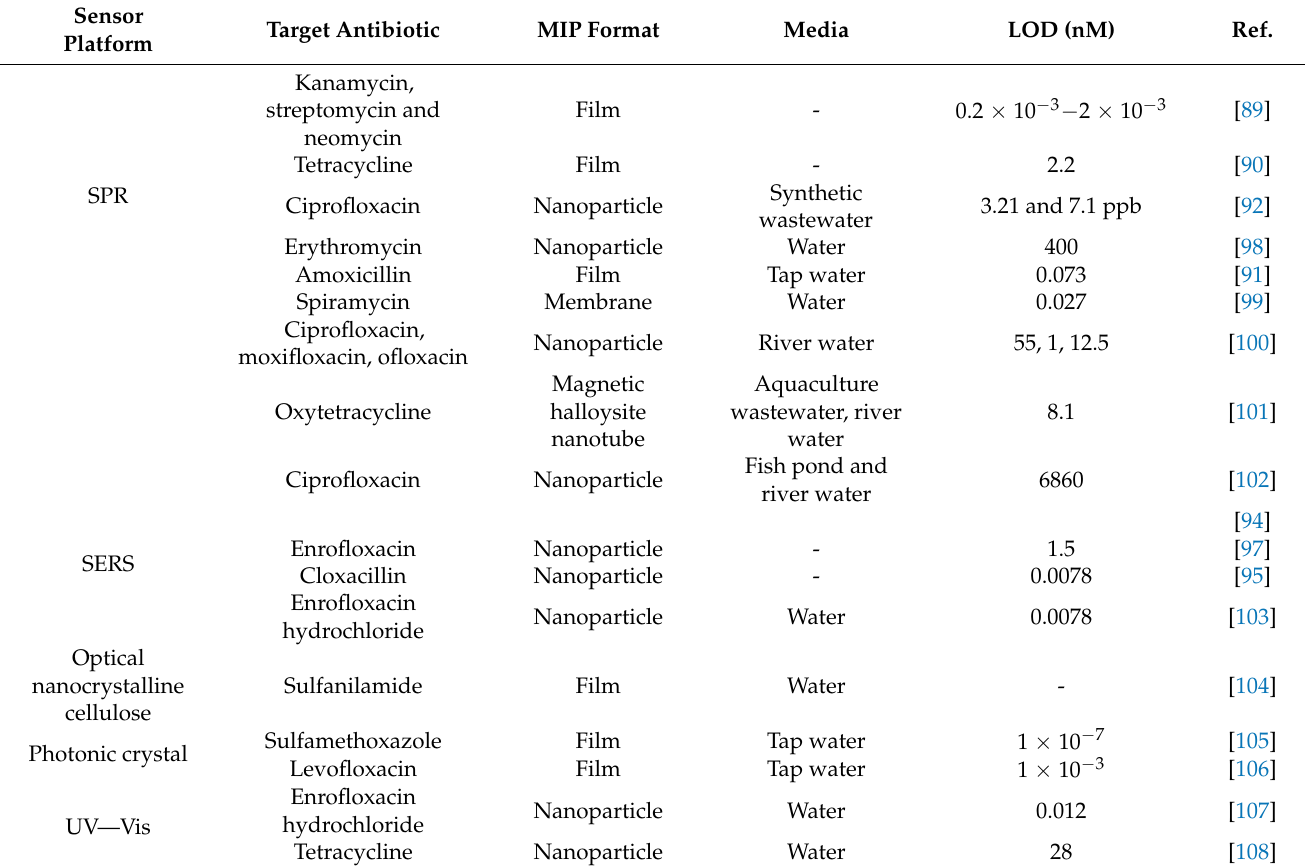
Table 2. Antibiotic MIPs combined with optical label-free sensor platforms and their performance. Sensor